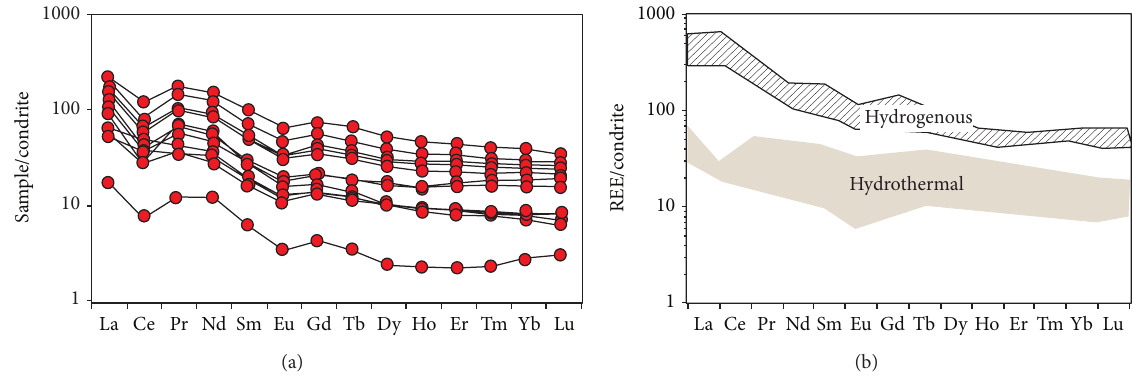
Figure 8: (a) Chondrite normalized REE diagram for ore samples (normalization values are from Evensen et al. [28]). (b) REE diagram showing hydrogenous [29] and hydrothermal [29]